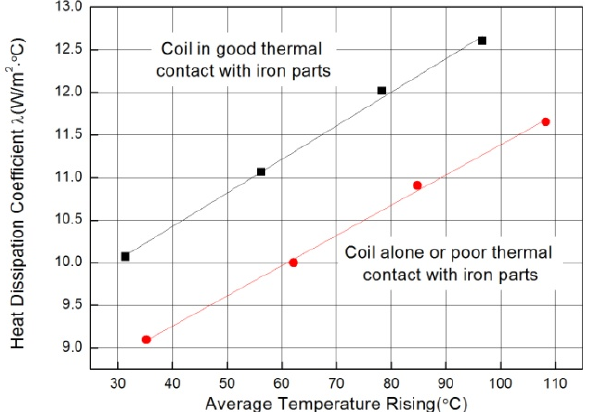
Figure 4. Heat dissipation coefficient with rising temperature.